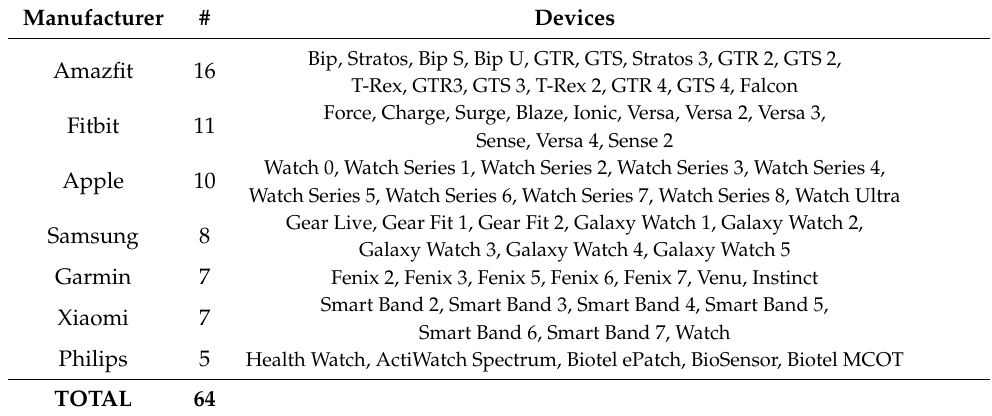
Table 3. Most used commercialized devices selected for this study, ordered by the manufacturer. Manufacturer